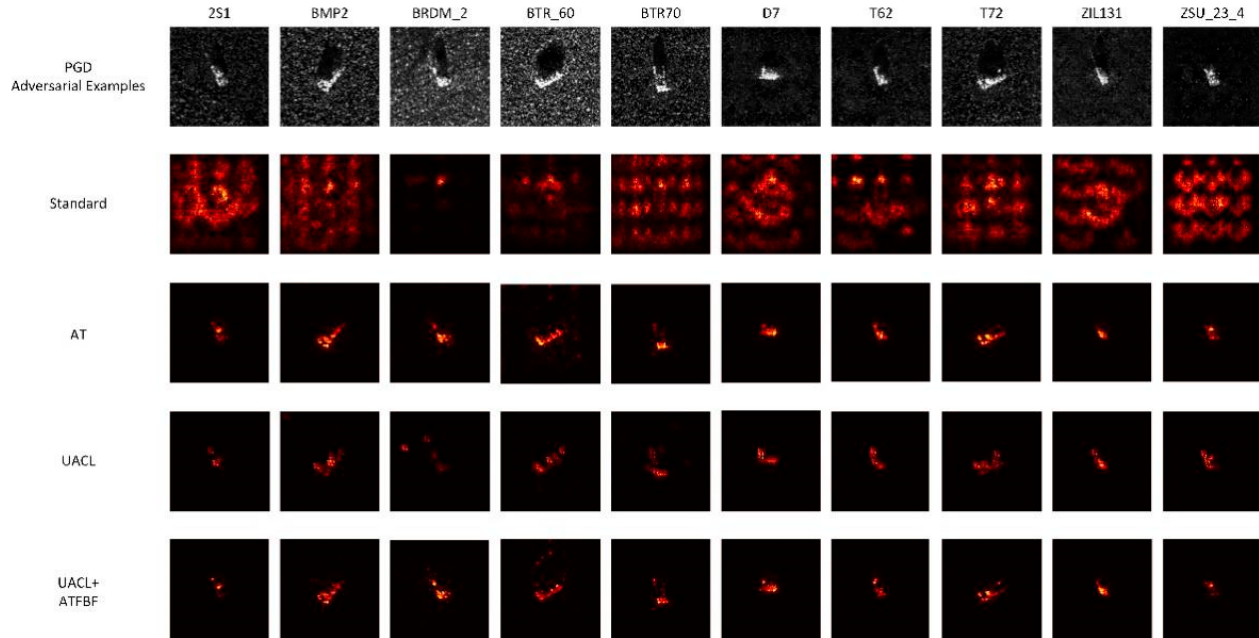
Figure 10. Guided backpropagation images of MSTAR model in the classification of adversarial examples.